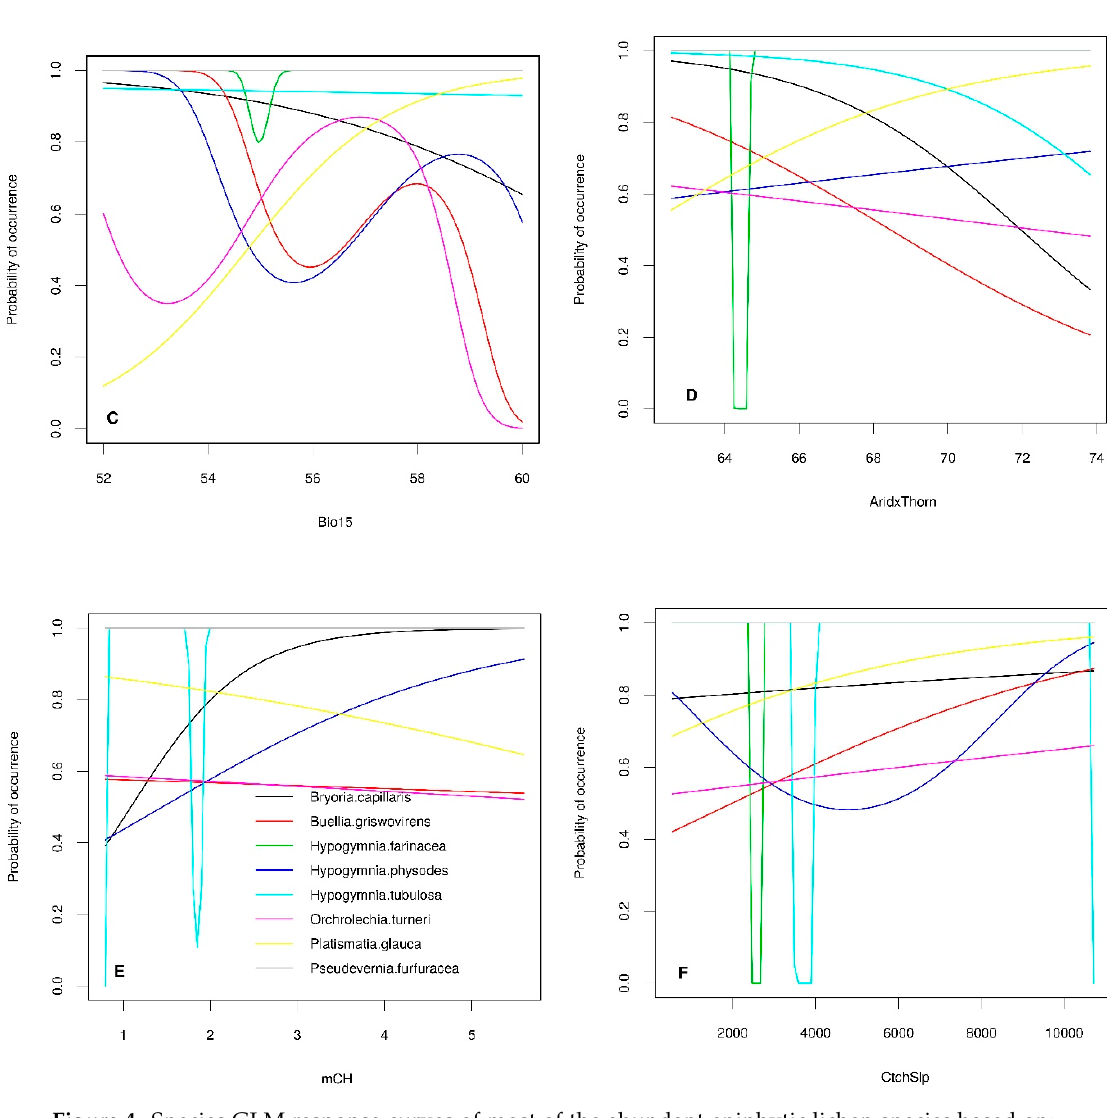
Figure 4. Species GLM response curves of most of the abundant epiphytic lichen species based on: ( A ) Elevation, ( B ) mDbh, ( C ) Bio15, ( D ) AridxThorn, ( E ) mCH, and ( F )